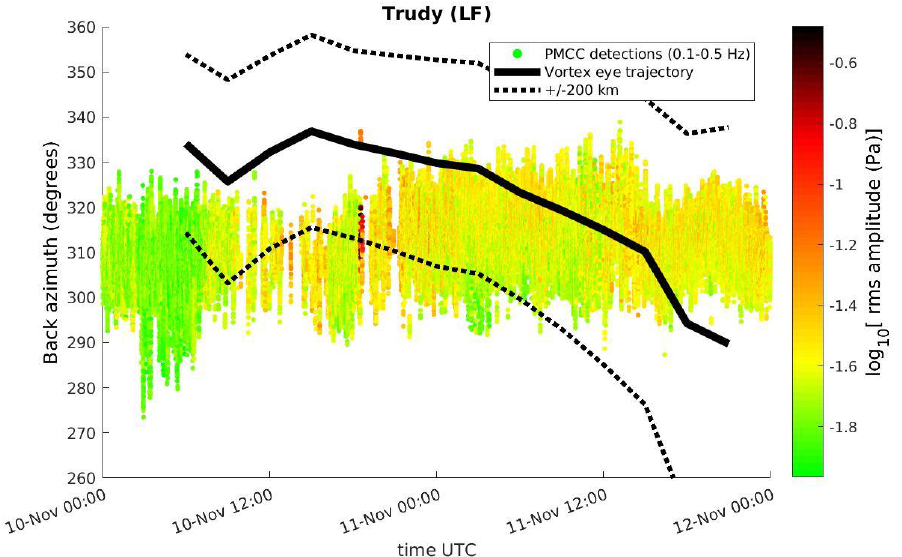
Figure 6. As in Figure 3 in the lower frequency (LF) range (0.1 – 0.5 Hz).